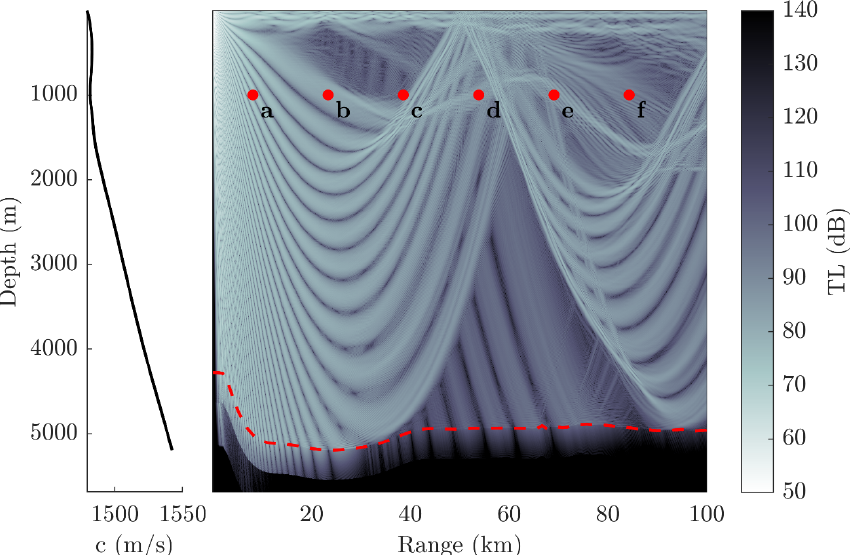
Figure 2. Sample TL-field. In this environment, the acoustic source is located at a range of 0 km and a depth of 72.3 m. The acoustic source frequency is 528.5 Hz. The sound speed profile corresponding to the water column properties at the source location is shown in the left panel. The environment’s bathymetry is shown as the dashed red line. The sediment type for this environment is clay, and the sediment thickness for this environment is 350.2 m. The six red points shown in the environment near 1000 m in depth are the example locations for the PDFs of TL shown in Figure 3.